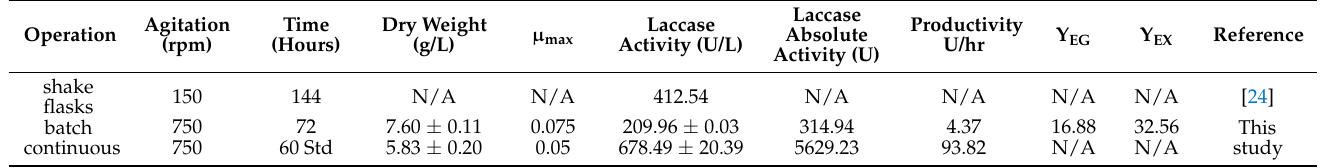
Table 7. The effects of mode of operation on the kinetic characterization of fermentation.